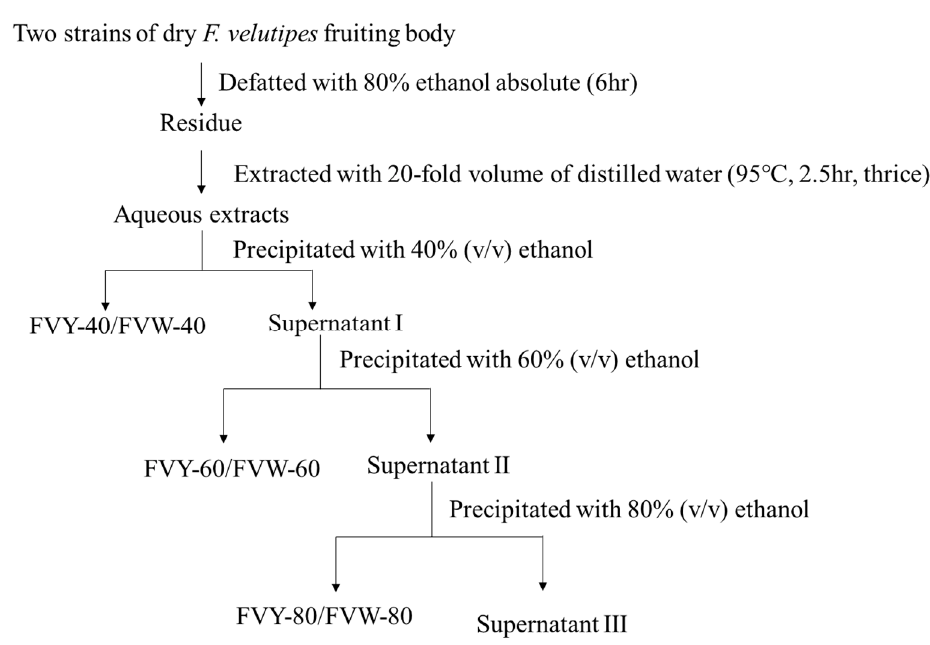
Figure 2. The flow chart of preparation of F. velutipes polysaccharides.